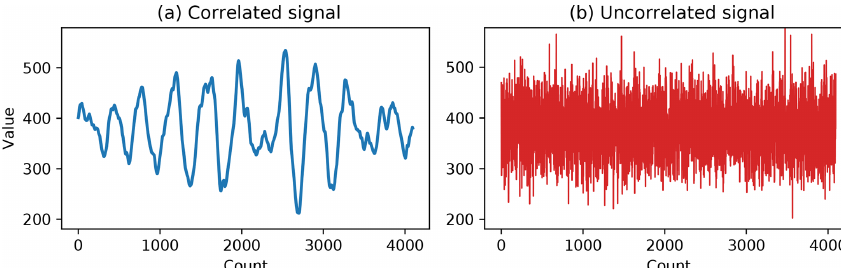
Figure 2. The signals used for illustration (a) correlated and (b) uncorrelated.